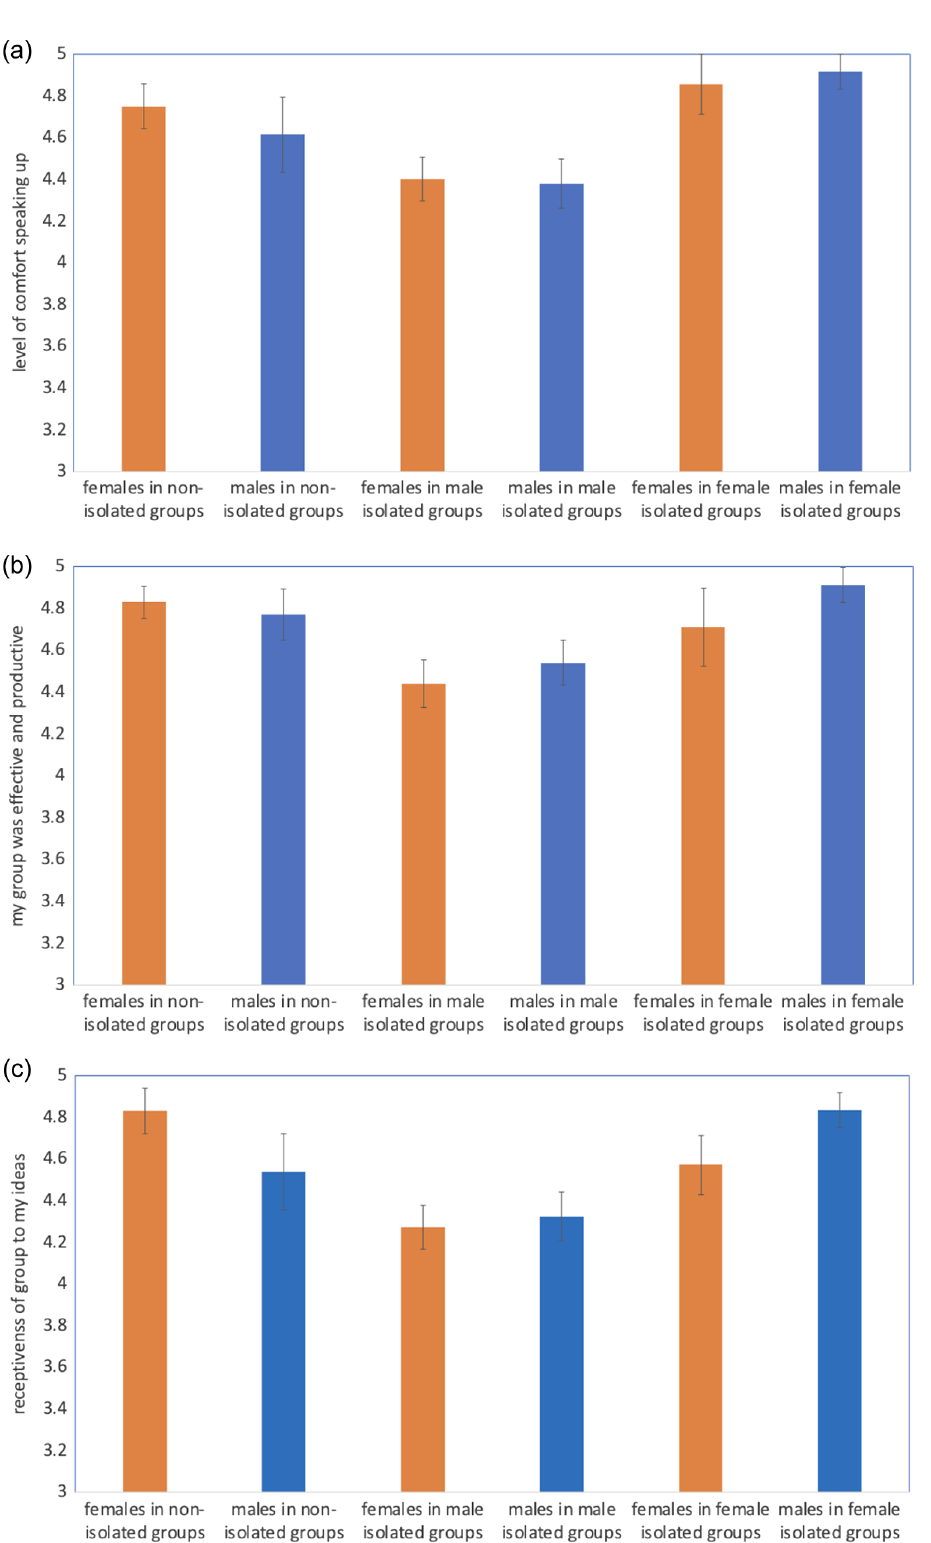
FIG. 7. (a) – (c) Average response of students in different subcategories based on their gender and type of group for survey questions: (a) During the group exam, I felt comfortable speaking up; (b) during the group exam, my group was effective and productive; and (c) during the group exam, my group members were always receptive to my ideas and